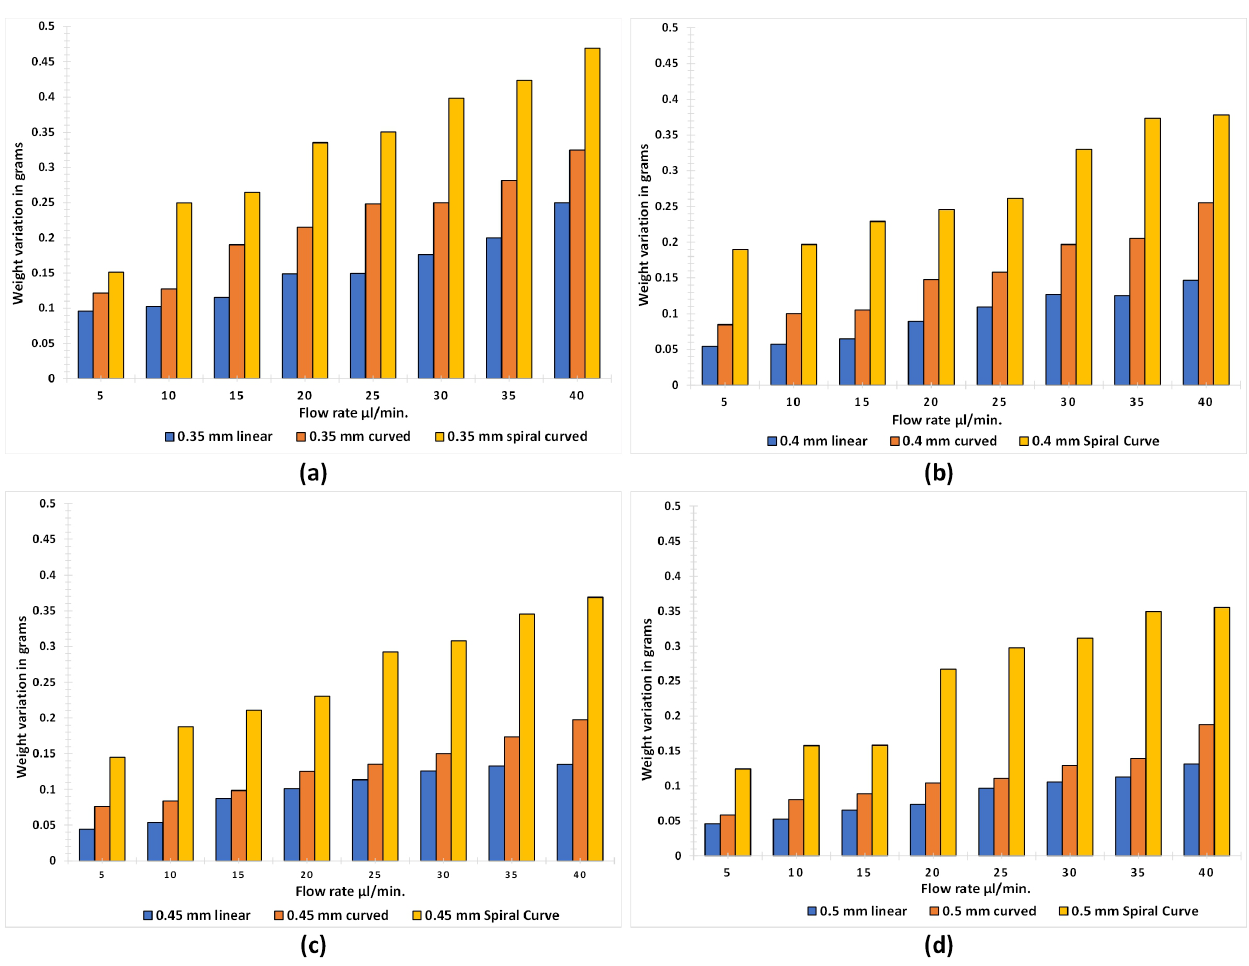
Figure 10. Weight analysis of linear, curved, and spiral microchannels with diameter size of ( a ) 0.35 mm, ( b ) 0.4 mm, ( c ) 0.45 mm, and ( d ) 0.5